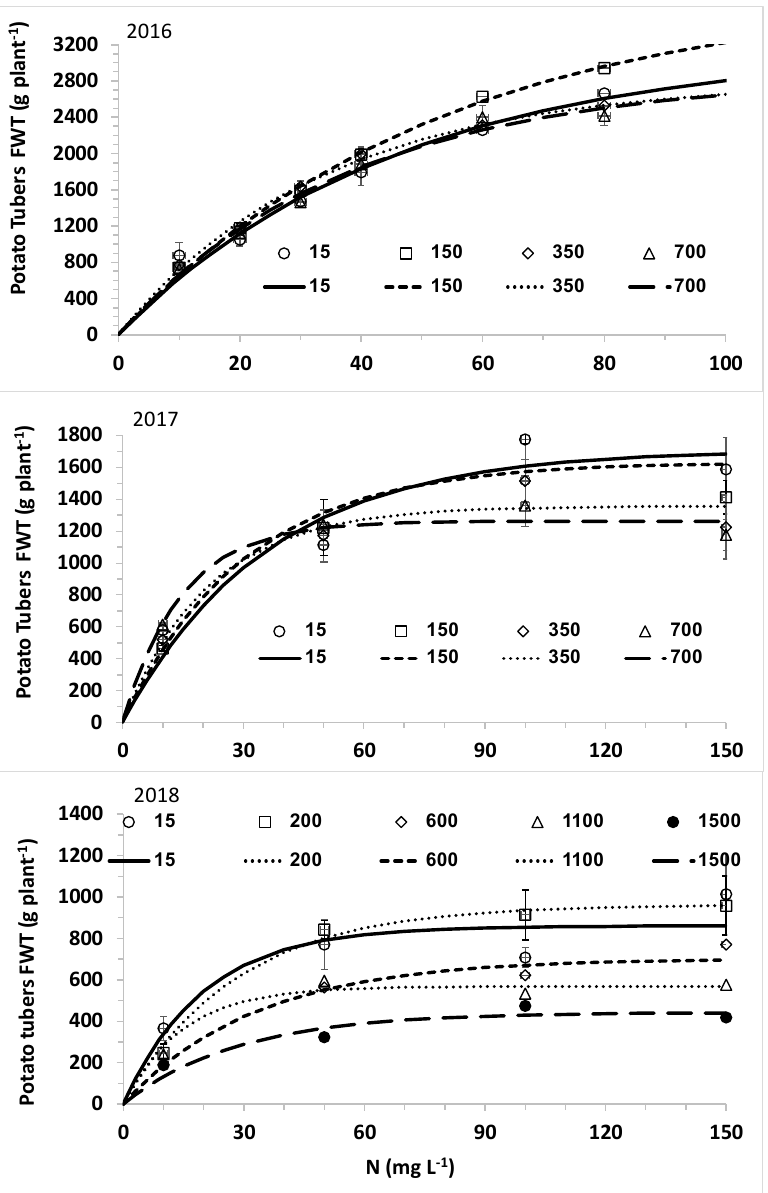
Figure 2. Potato tubers fresh weight (FWT) as a function of N concentration in the irrigating solution at different Cl concentrations in the irrigating solution, ( bottom ) 26 May 2016, ( middle ) May 2017, and ( top ) May 2018.